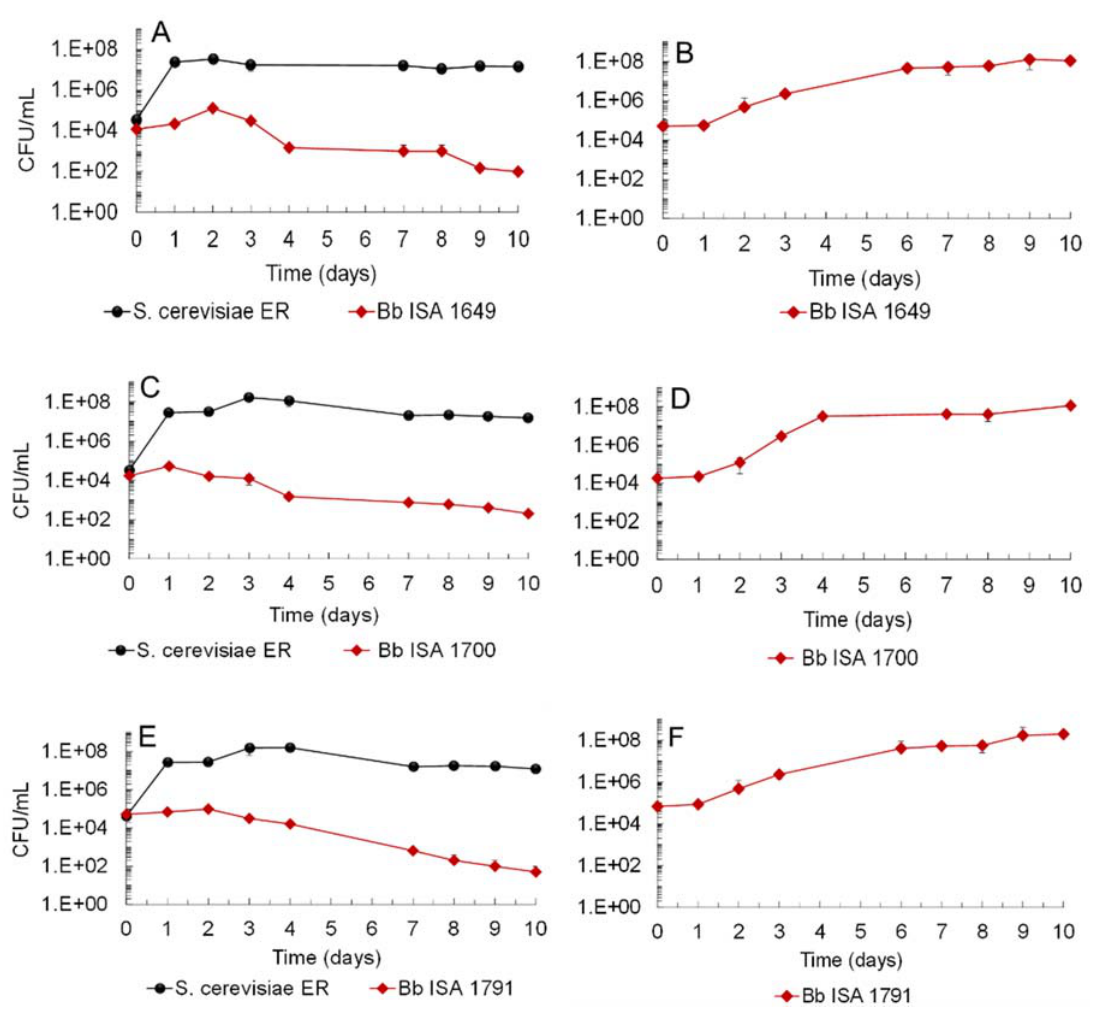
Figure 2. Culturability of S. cerevisiae ER and B. bruxellensis (Bb) during alcoholic fermentations performed with Bb strains ISA 1649 ( A , B ), ISA 1700 ( C , D ) and ISA 1791 ( E , F ) in mixed-culture with S. cerevisiae ER ( A , C , E ) and in single-culture ( B , D , F ). Data represented correspond to means ± SD (error bars) of two independent biological assays.